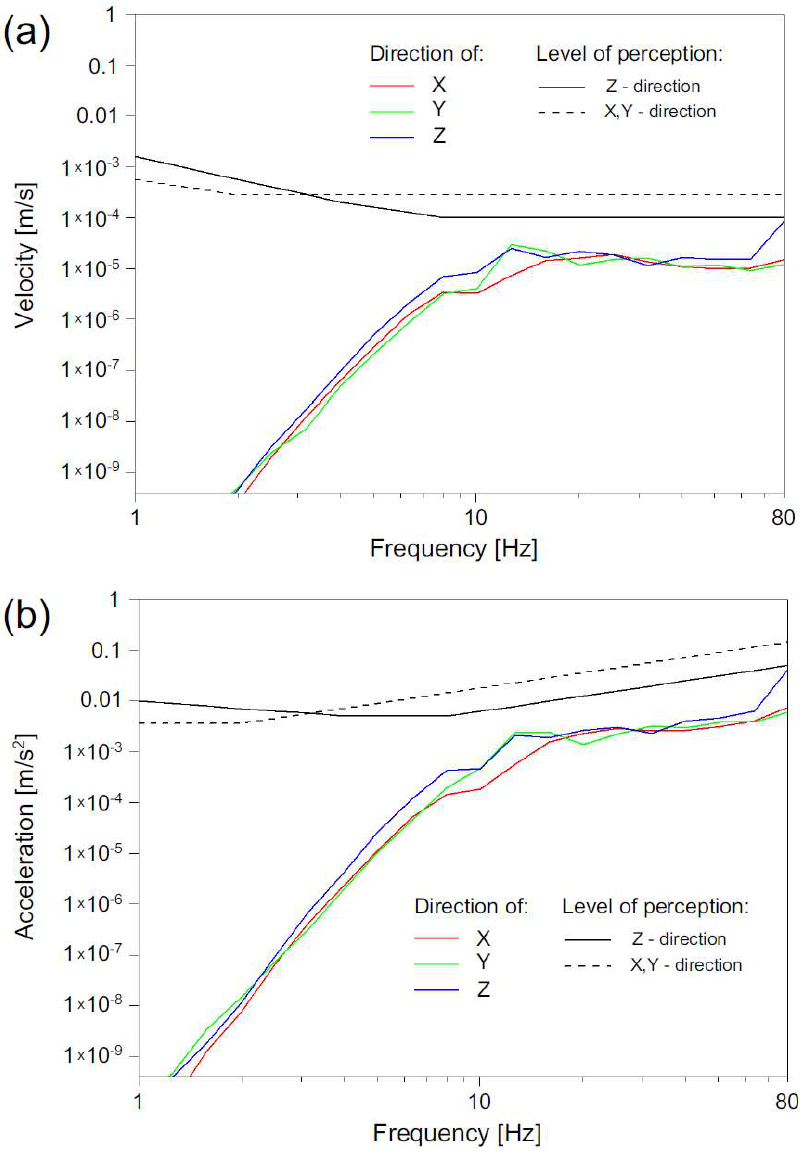
Figure 9. Comparison of velocity ( a ) and acceleration ( b ) levels to perception levels for horizontal ( x , y ) and vertical ( z ) directions of point No. IX.